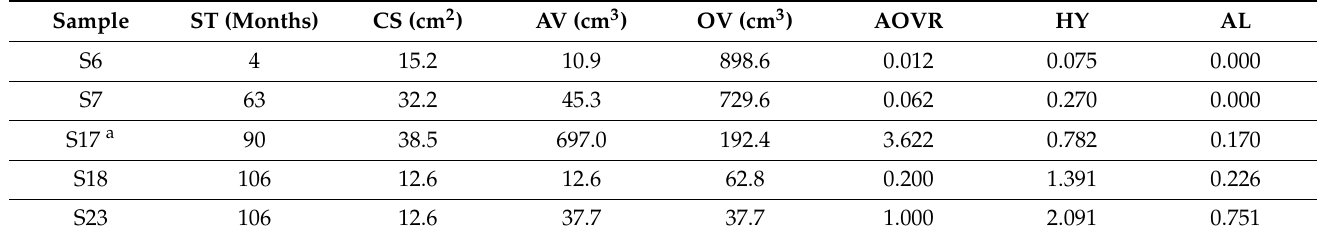
Table 4. Oxidation conditions during storage of sunflower oil samples: storage time (ST), air/oil contact surface (CS), air volume (AV), oil volume (OV), air/oil volume ratio (AOVR) together with the relative molar proportions of hydroperoxides (HY) and aldehydes (AL) [39].